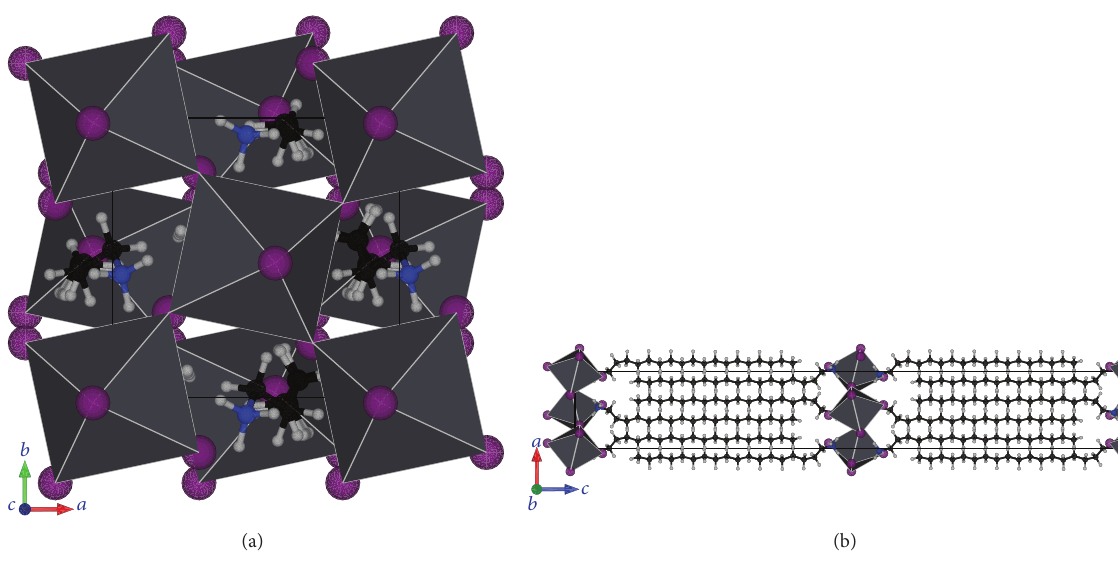
Figure 3: (a) Overview of the monoclinic crystal structure of (C 18 H 37 NH 3 ) 2 PbI 4 projected in the (𝑏, 𝑐) plane. (b) Overview of the low- temperature crystal structure of (C 18 H 37 NH 3 ) 2 PbI 4 projected into the (𝑎,𝑏)